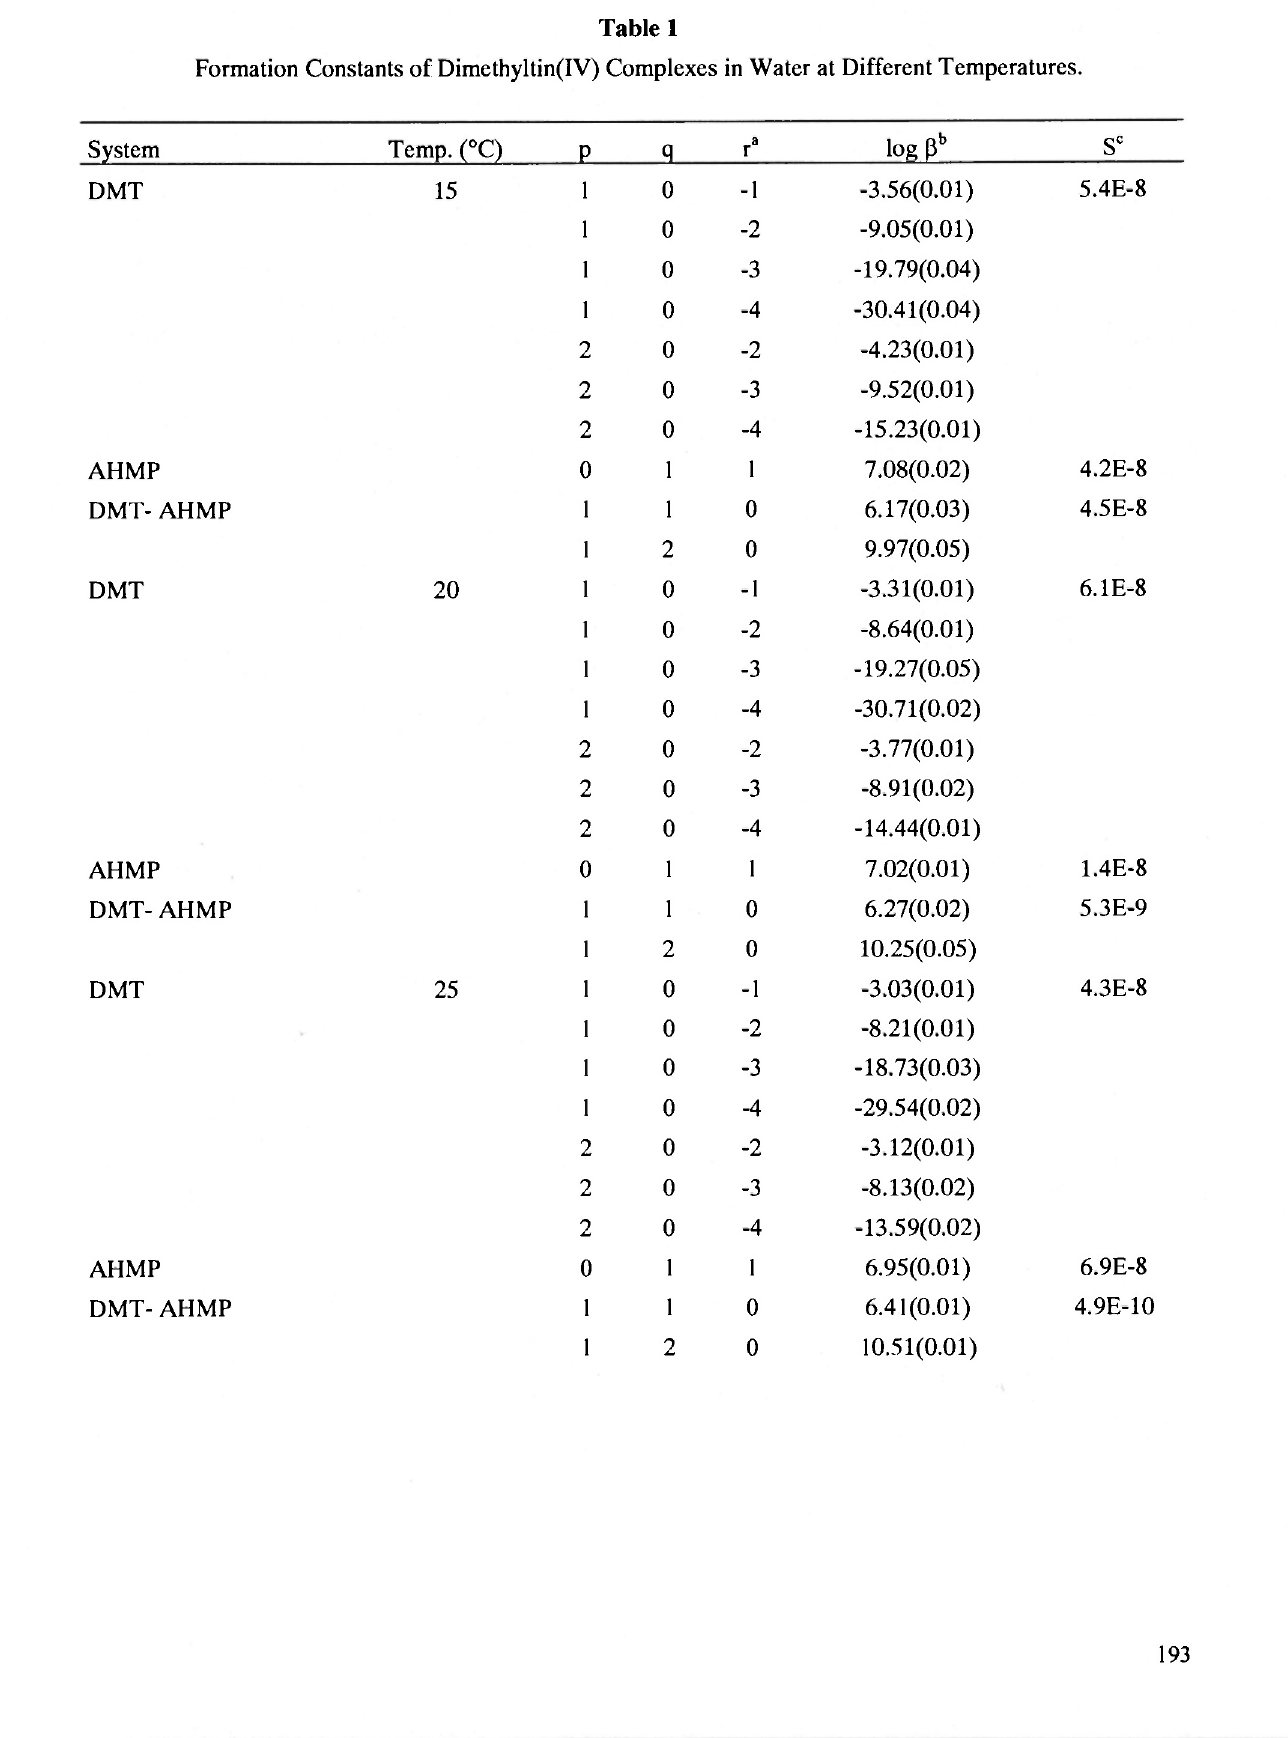
Formation Constants of Dimethyltin(IV) Complexes in Water at Different Temperatures.